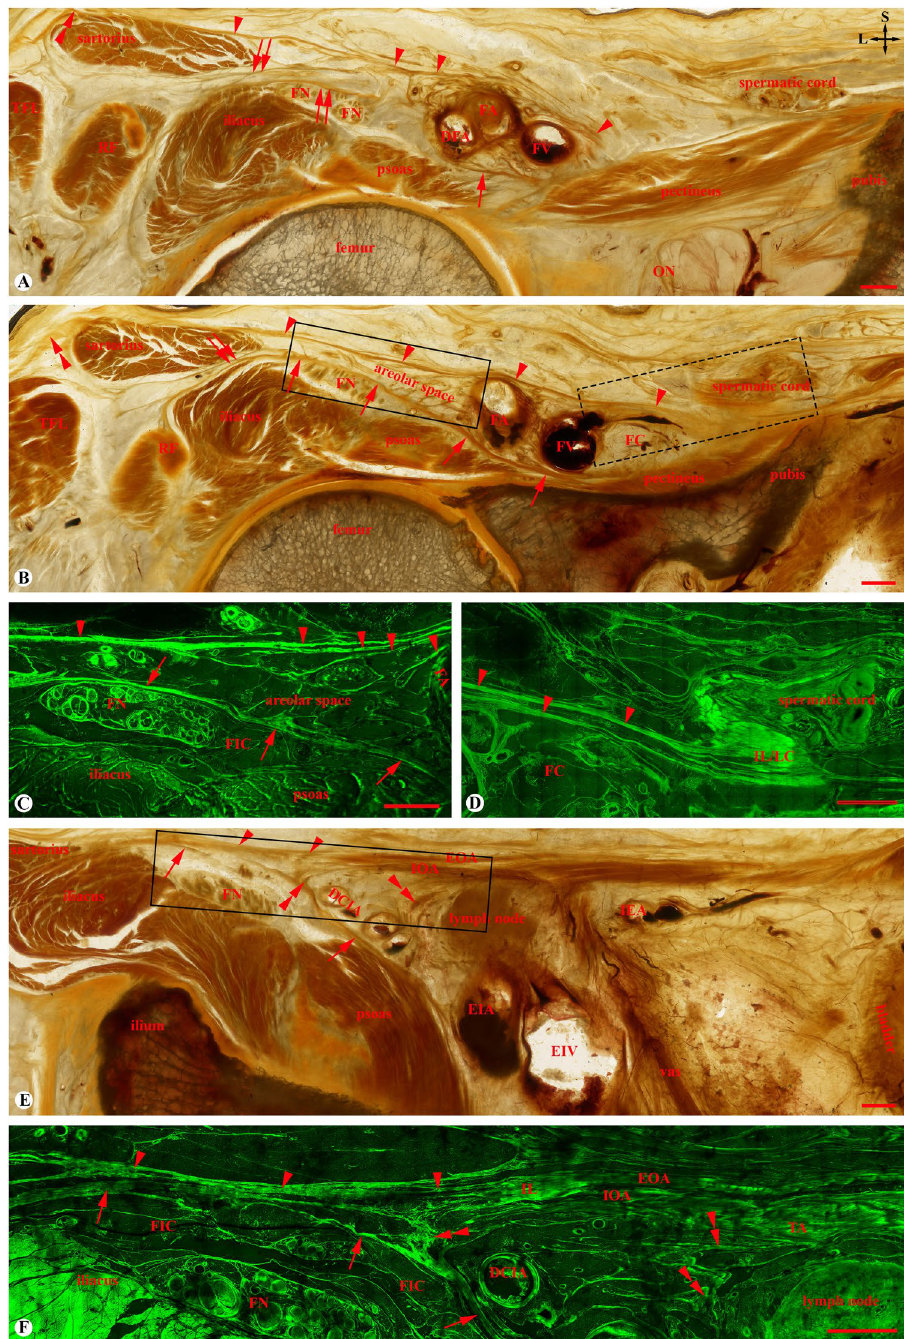
Figure 2. Fascia iliaca compartment on three adjacent transverse sections at the levels of the medial ( A ), middle ( B ) and lateral ( E ) thirds of the inguinal ligament, respectively. ( A ) The fascia iliaca appears as a medial psoas part (single arrow) which contributes to the posterior wall of the femoral vascular sheath, and a lateral conjoint tendinous sheet part (double arrows). Single arrowheads: fascia lata originated from the inferior prolongation of the inguinal ligament; Double arrowheads: fascia lata originated from the iliolata ligaments; DFA: deep femoral artery; FA: femoral artery; FN: femoral nerve; FV: femoral vein; ON: anterior division of the obturator nerve; RF: rectus femoris; TEF: tensor fascia lata. ( B–D ) The intact fascia iliaca (single arrows) covers the femoral nerve (FN), laterally receives aponeurotic fibers (double arrows) from the iliacus, rectus femoris (RF) and sartorius, and medially merges with the pectineal fascia. FC: femoral canal. ( C , D ) are the mirror confocal images of the solid and dashed line boxes in ( B ) showing the multiple-layered fascia lata (single arrowheads) originated from the inferior prolongation of the inguinal (IL) and lacunar ligaments (LC) and contributed to the anteromedial wall of the femoral vascular sheath. The epineurium of the femoral nerve (FN) is within the fascia iliaca compartment (FIC). ( E , F ) Aponeurotic fibers of the psoas and iliacus (single arrows), and the internal oblique abdominis (IOA) and transverse abdominis (TA) (double arrowheads) are intermingled to form